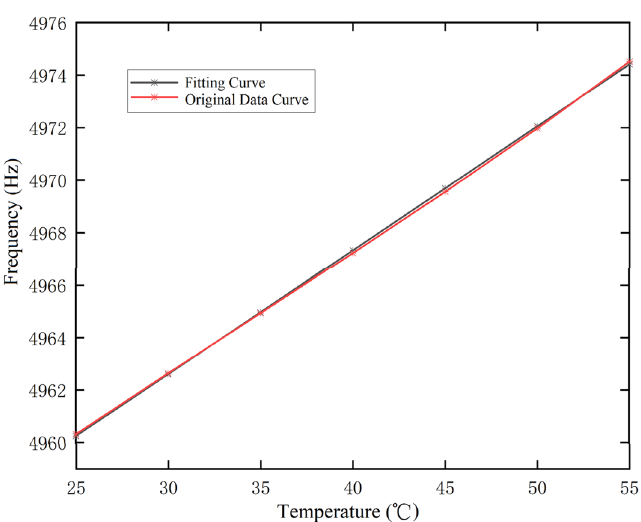
Figure 4. Fitting relationship between resonant frequency and temperature.